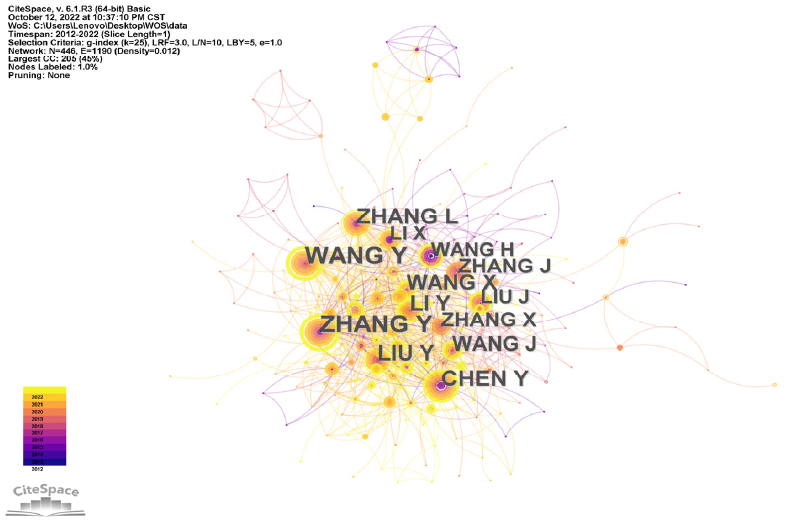
Figure 14. Author cooperative network for research on rural human settlements.